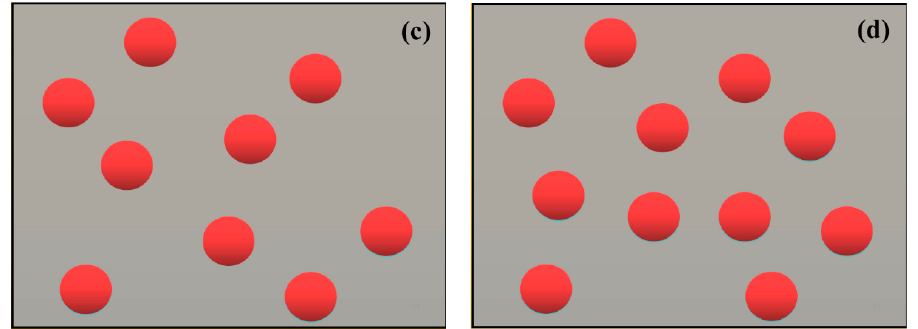
Figure 2. Schematic diagrams of the free volume for (TiZr) 0.5 (Ni 0.6 Cr 0.1 V 0.1 ) 2.1 ribbons with different spinning speeds. The spinning speed were ( a ) 30m/s, ( b ) 35 m/s, ( c ) 40 m/s, and ( d ) 45 m/s, respectively.